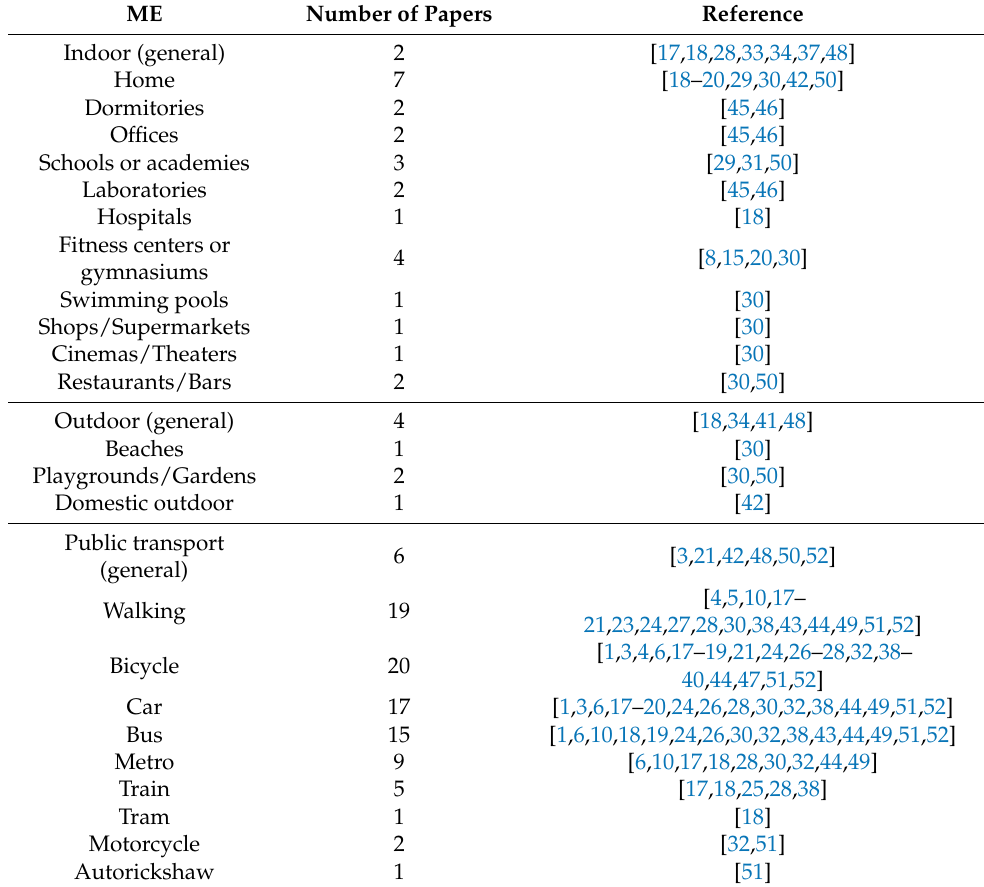
Table 3. MEs considered in the studies